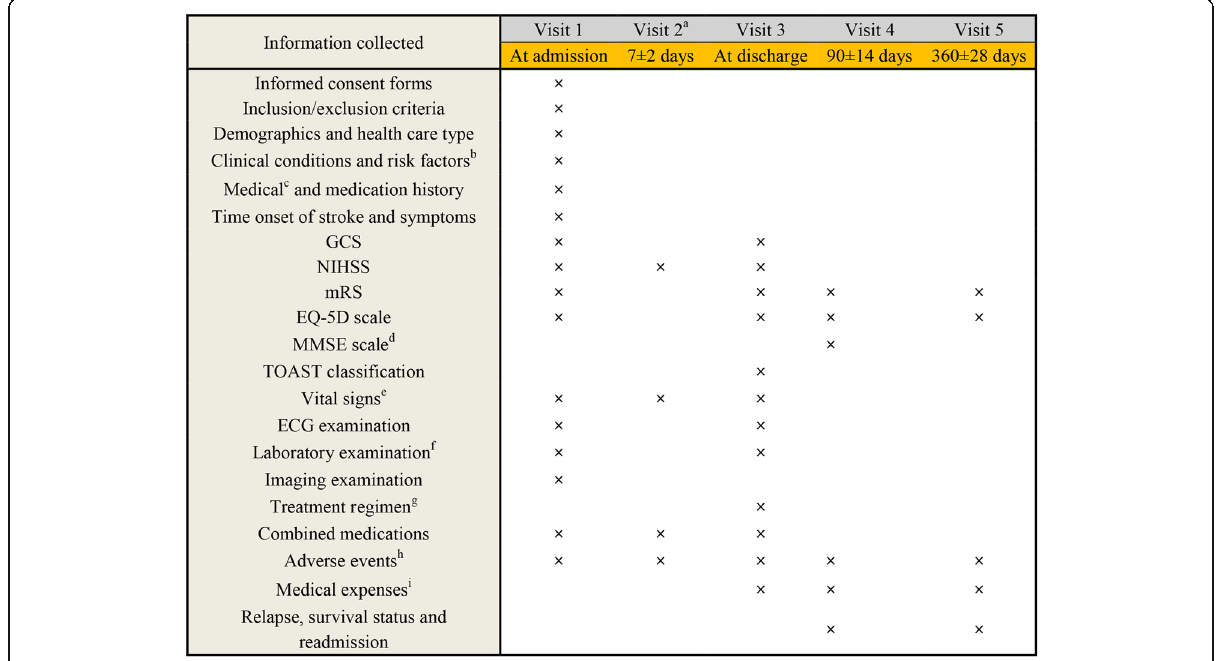
Fig. 1 Study schedule of assessments. GCS, Glasgow coma Scale; NIHSS, National Institutes of Health Stroke Scale; mRS, Modified Rankin Scale; EQ-5D, EuroQol-5 Dimensions; MMSE, Mini-mental state examination; TOAST, Trial of Org 10,172 in Acute Stroke Treatment; ECG, Electrocardiograph. a. Visit